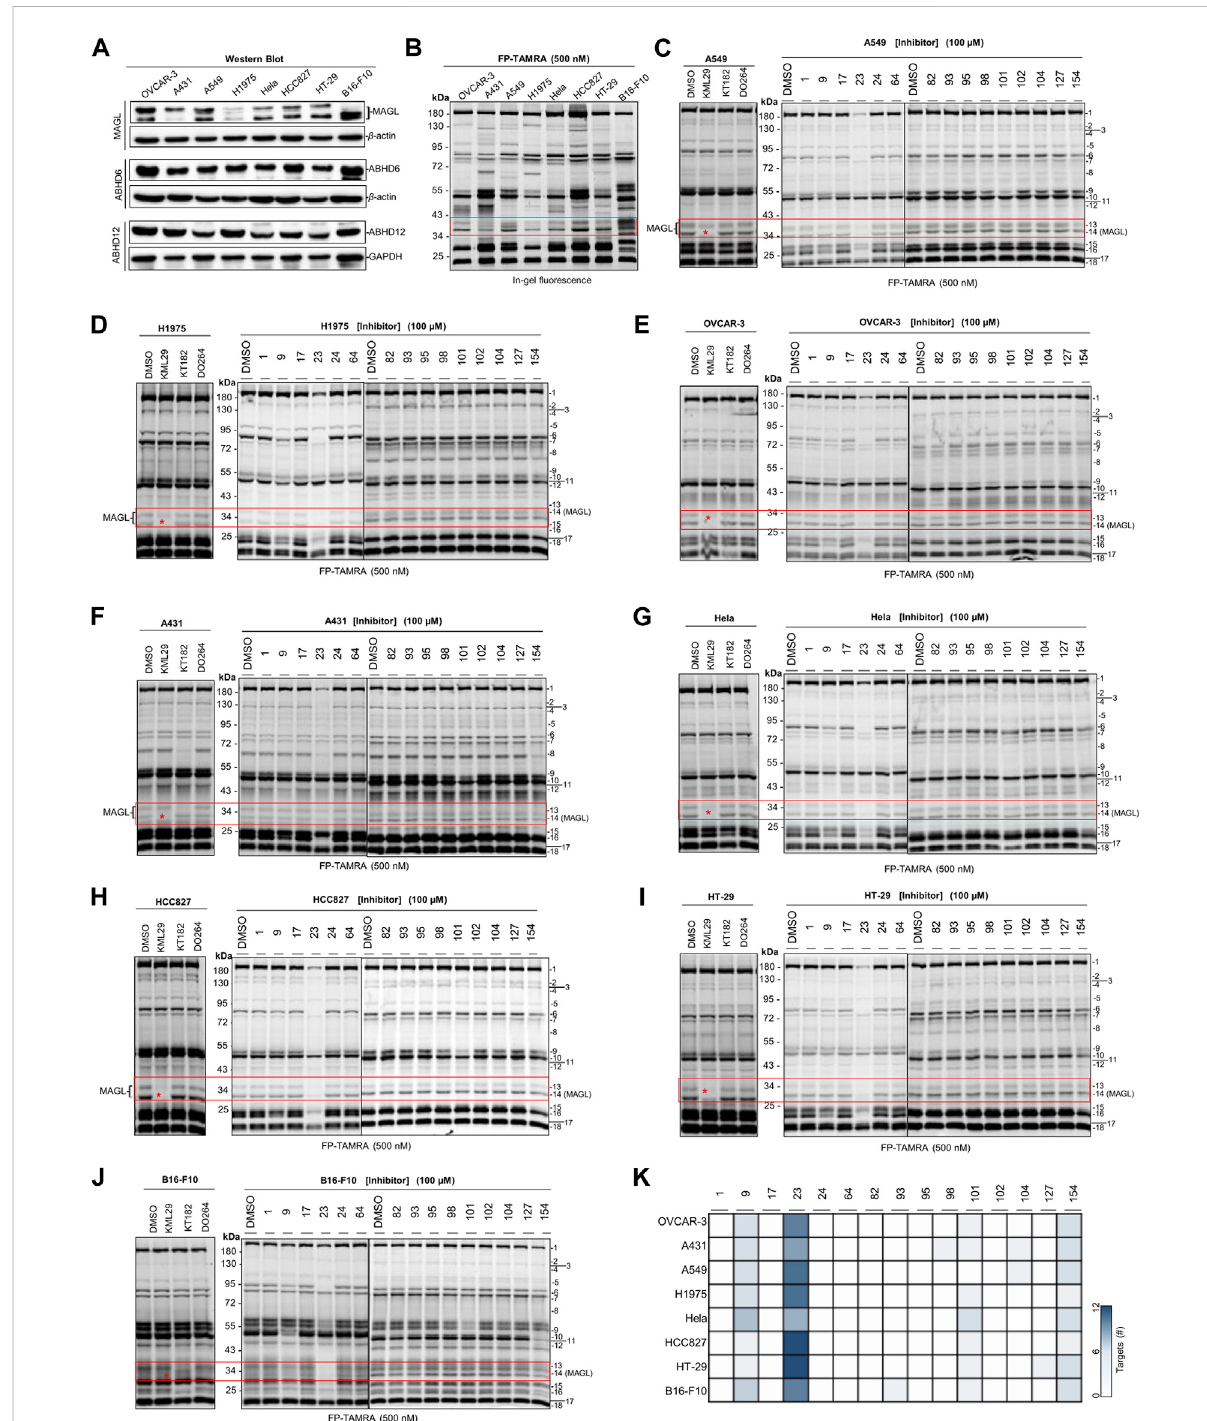
FIGURE 5 Screening several cancers cells lines to identify thepotential target(s) of compounds with antiproliferative activitiesusing competitiveABPP. (A) Western blot analysis of the expression of endogenous MAGL, ABHD6, and ABHD12 in the cancer cell lines. (B) Comparative ABPP analysis of the potential targets labeled by serine hydrolase probe FP-TAMRA. (C – J) Competitive ABPP gel results of compounds 1 , 9 , 17 , 23 , 24 , 64 , 82 , 93 , 95 , 98 , 101 , 102 , 104 , 127, and 154 showtheselectivitypro fi leacrossserinehydrolaseslabeledbyFP-TAMRA(500 nM).Notethattheconcentrationof KML29, KT182, and DO264 was 10 μ M, respectively. (K) Heatmap overview of the number of potential targets (identi fi ed by the quanti fi cation of protein bands in ABPP) for compounds with antiproliferative activities in various cancer